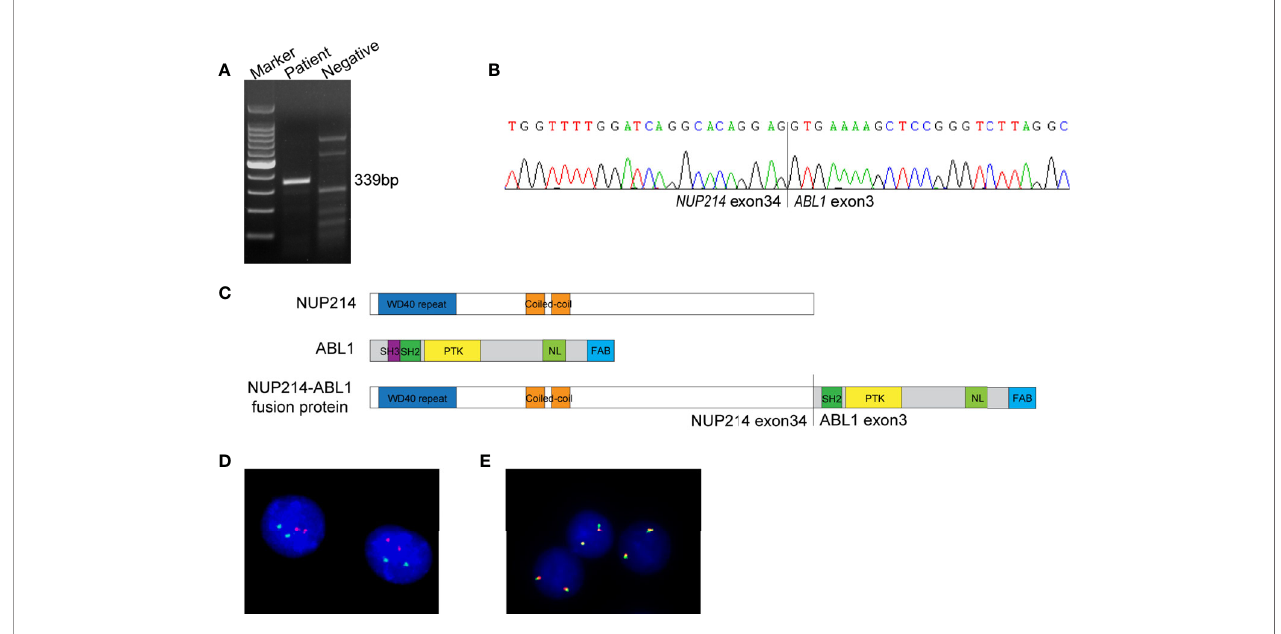
FIGURE 2 | (A) RT-PCR for the NUP214-ABL1 fusion transcript. The expected product size was 339 bp. (B) Sanger sequencing of the PCR product con fi rmed the NUP214-ABL1 fusion gene of exon 34 of NUP214 to exon 3 of ABL1 . (C) The structure of NUP214-ABL1 fusion protein. PTK, protein tyrosine kinase; NL, nuclear localization; FAB, F-actin binding. (D) FISH showed normal signal pattern using BCR/ABL1 dual-color dual-fusion probe. (E) FISH showed two intact ABL1 signals using an ABL1 break-apart